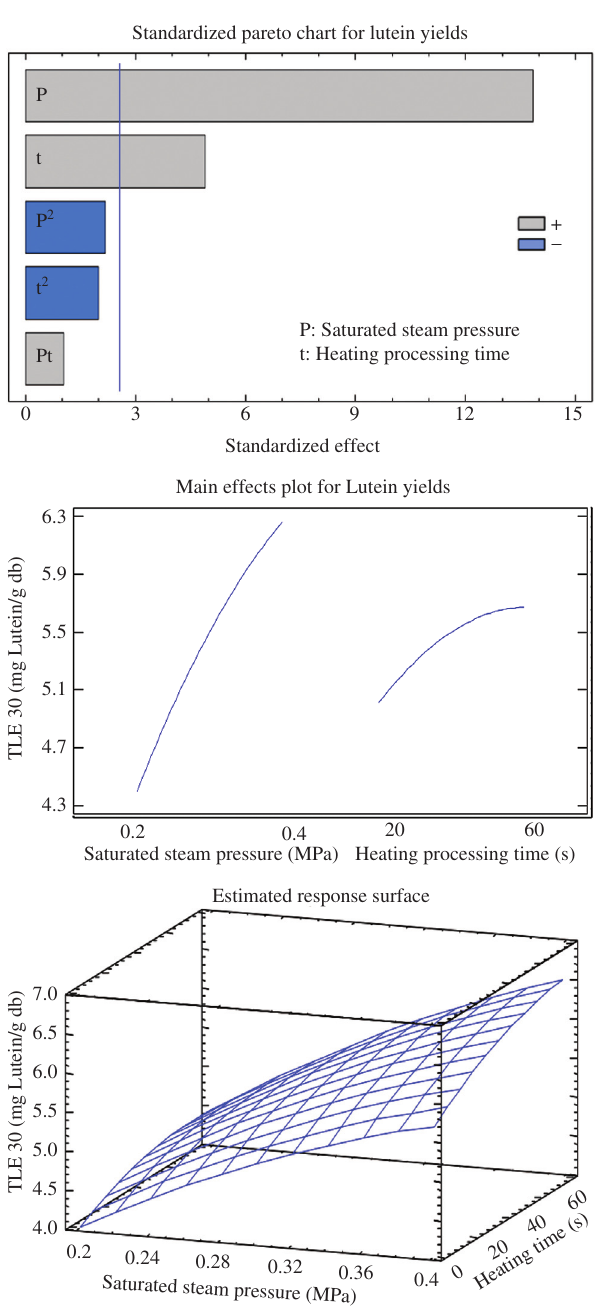
Figure 8 Pareto chart of lutein yield and general trends and response surface of instant controlled pressure drop (DIC)-treated microalgae